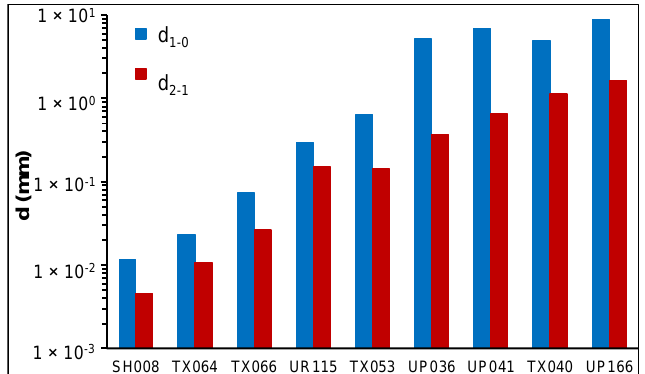
Figure 16. Maximum absolute displacement between the gravity centers at L0, L1 and L2 for the considered seismic events.